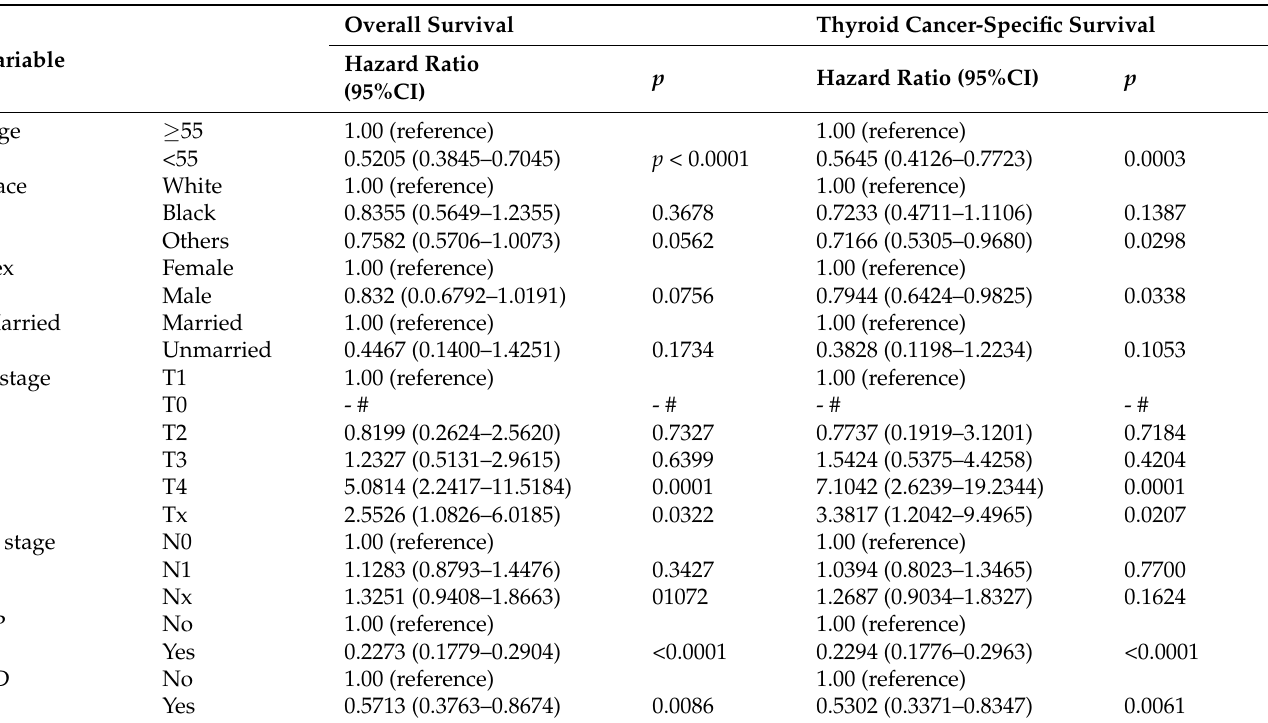
Table 2. Multivariable analyses of overall survival and thyroid cancer-specific survival in TC patients with lung metastasis from thyroid cancer.